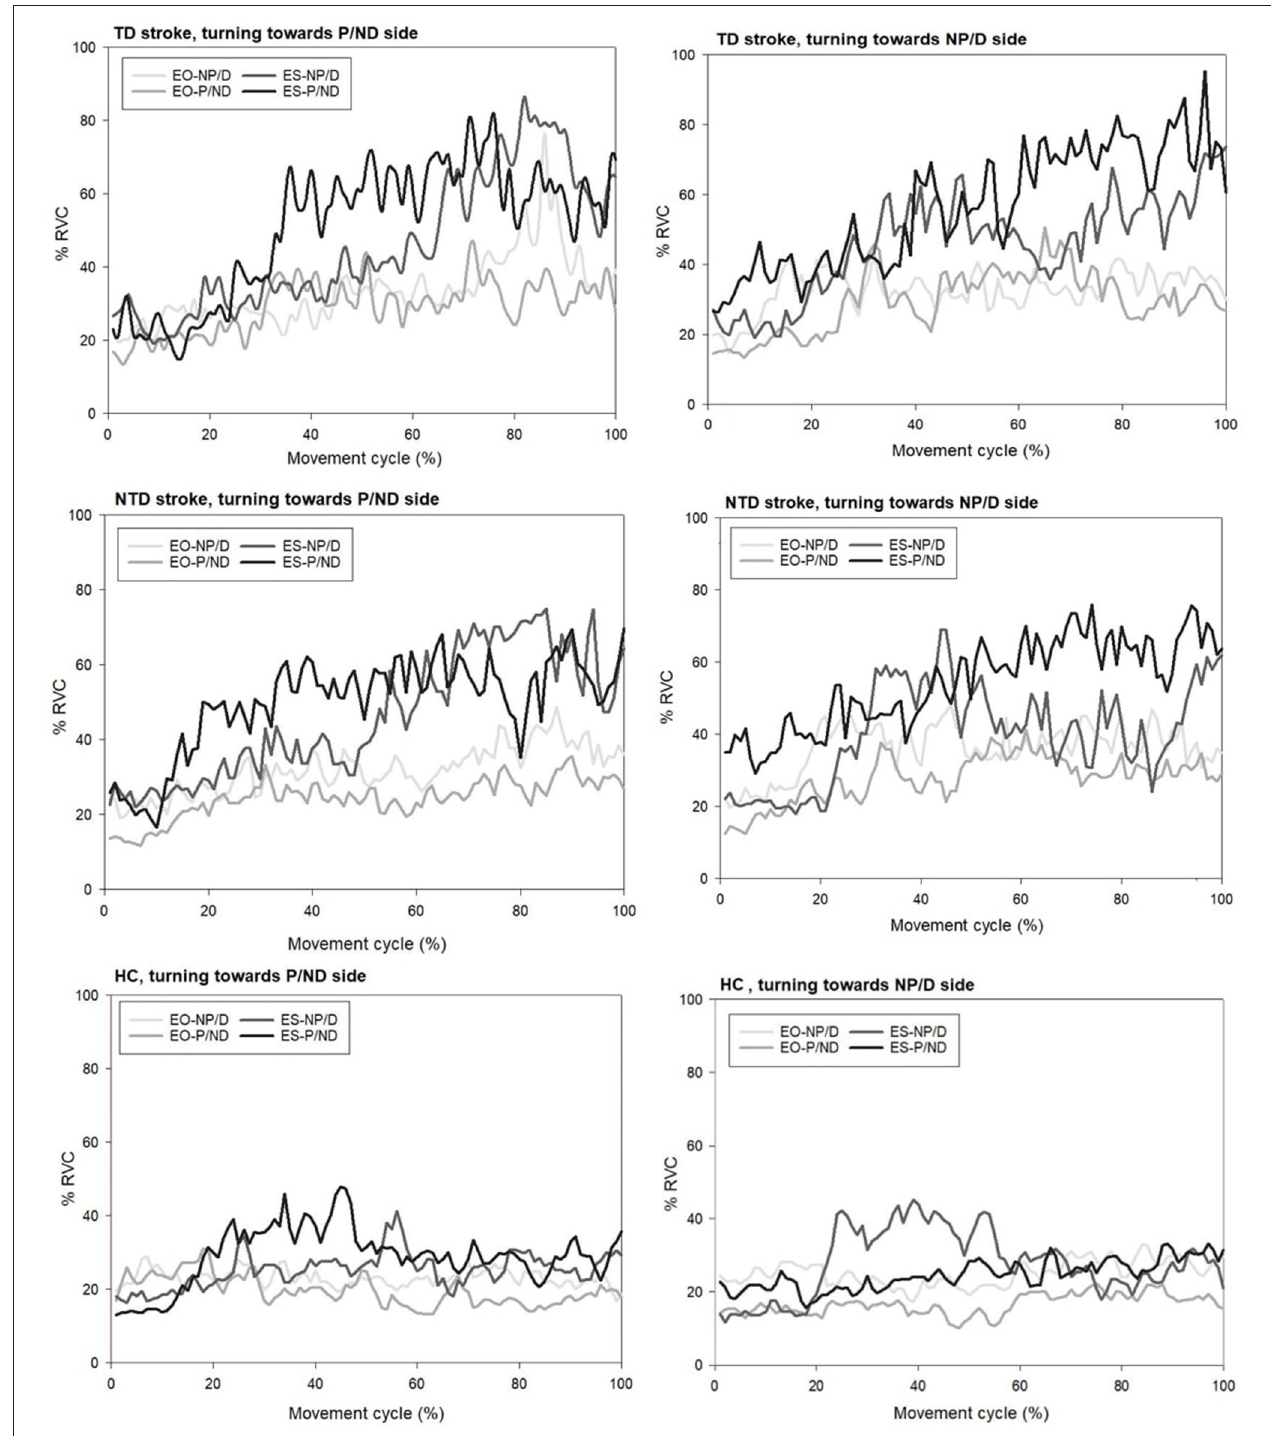
FIGURE 2 | Representative plots of trunk muscle amplitudes for participants with stroke with and without turning difficulty and healthy controls when performing standing 90 ◦ turn tasks toward both sides. EO, external oblique muscle; ES, erector spinae; TD, turning difficulty; NTD, no turning difficulty; P, paretic side; NP, non-paretic